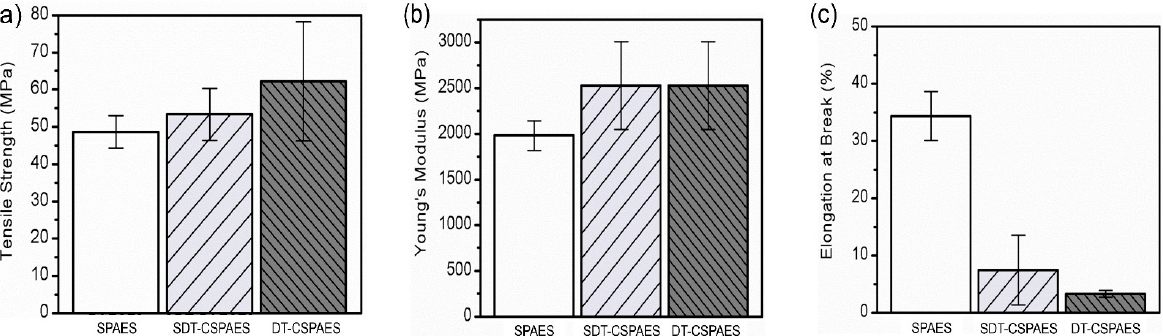
Figure 5. ( a ) Tensile strength, ( b ) Young’s modulus, and ( c ) elongation at break values of all the membranes at 25 °C and 40% RH.